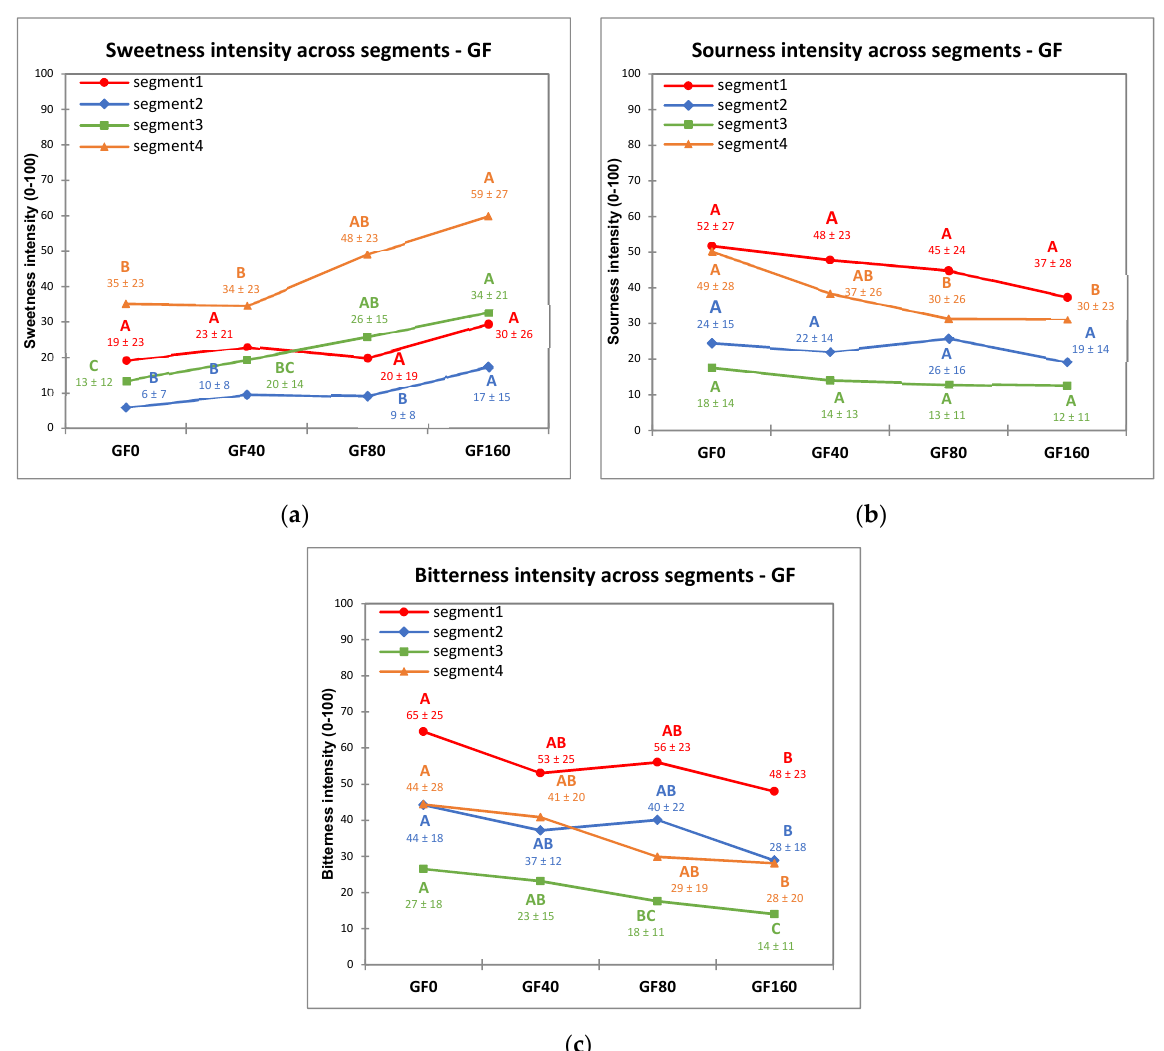
Figure 3. Taste intensity rating in grapefruit juice samples (mean intensity rating ± SD), (GF; 0–160 g/L added sucrose) for: sweetness ( a ), sourness ( b ) and bitterness ( c ) across the four segments. Different letters indicate significant differences ( p < 0.05) from Tukey’s HSD test across concentrations within each segment.